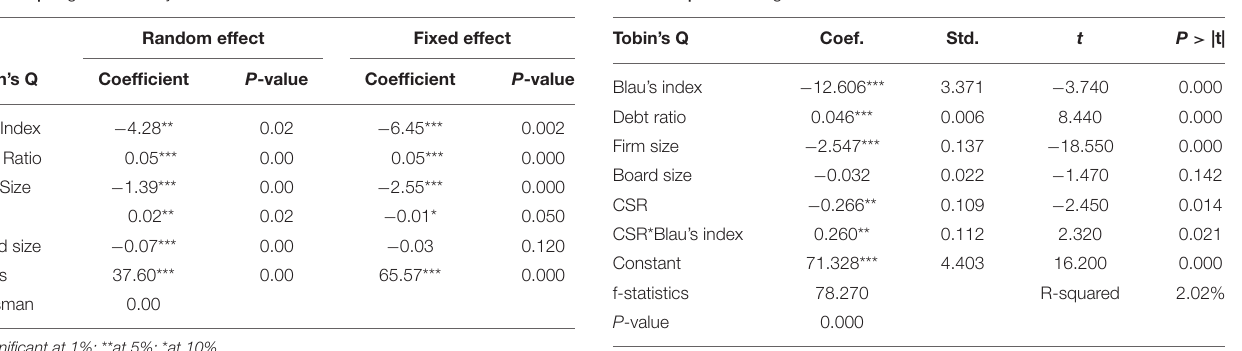
TABLE 4 | Regression analysis.